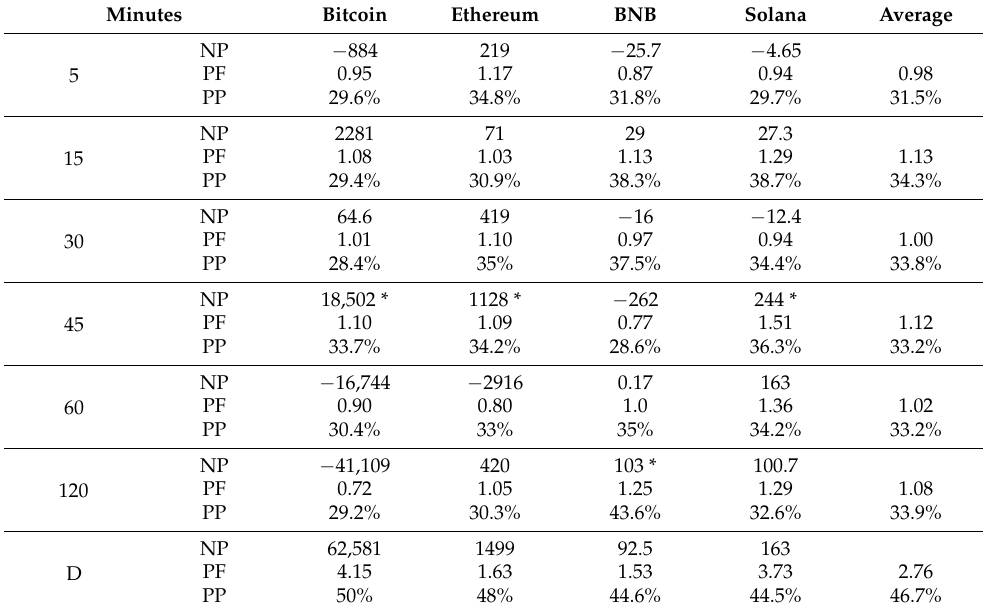
Table 6. Results of Multi-Layers trading algorithm.